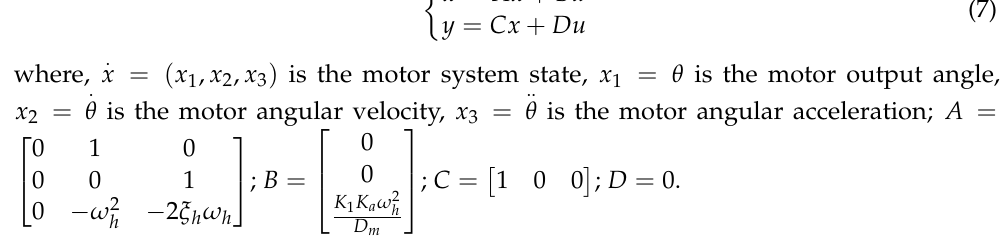
( ) s θ i is the input angle command signal; K is the main controller;